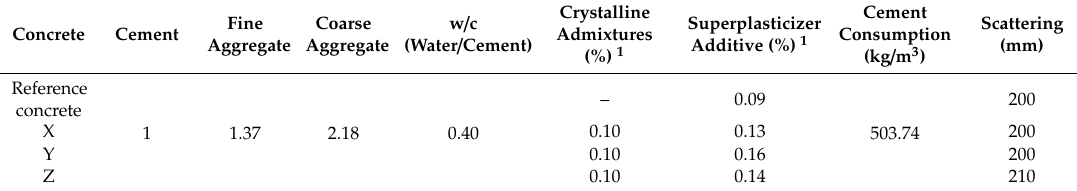
Table 4. Mix proportions in kg.